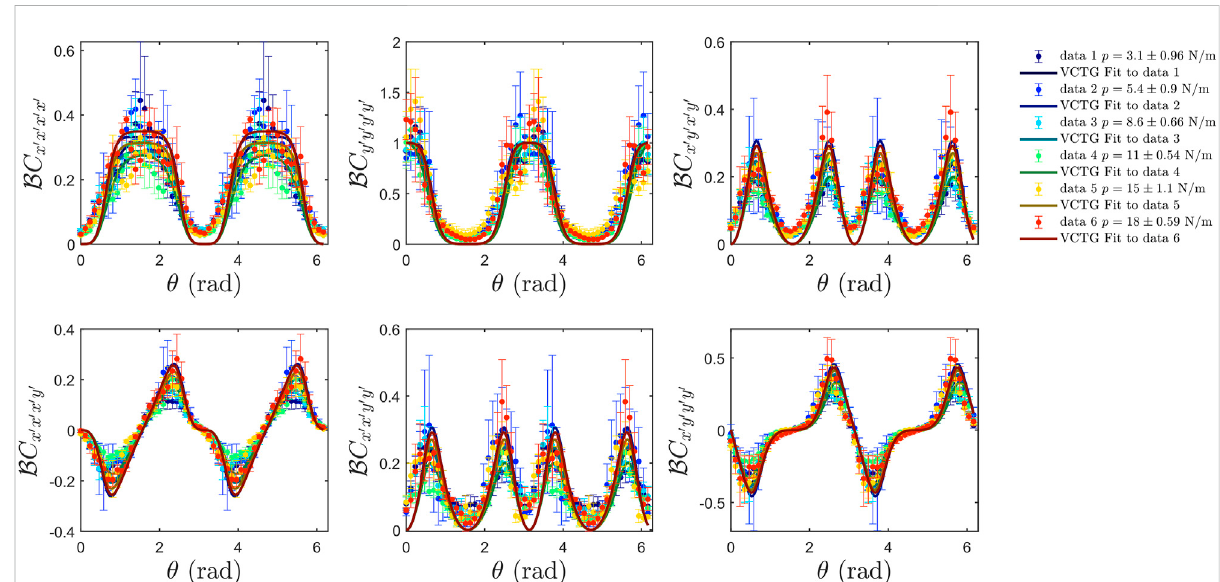
FIGURE 9 Angular variation of the stress correlations for ultrastable states in the long-wave-length limit and the fi tted results from VCTG assuming an uniaxial symmetry. Correlation functions are normalized by the VCTG fi tting parameter B , whose variation with p are shown inFigure 10A. The long- wavelengthlimitvaluesareestimatedbyaveragingdatawith q between2 π /6 d s and2 π /16 d s where d s isthediameterofthesmallerdiscparticleinour